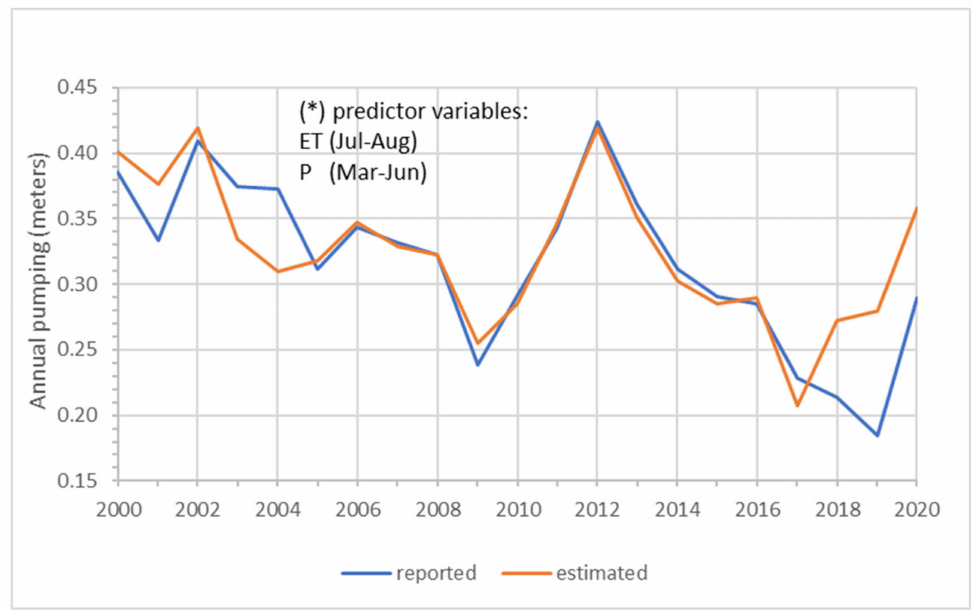
Figure A3. GMD 4 reported and estimated * pumping 2000–2020 using a regression based on 2005–2017 data.